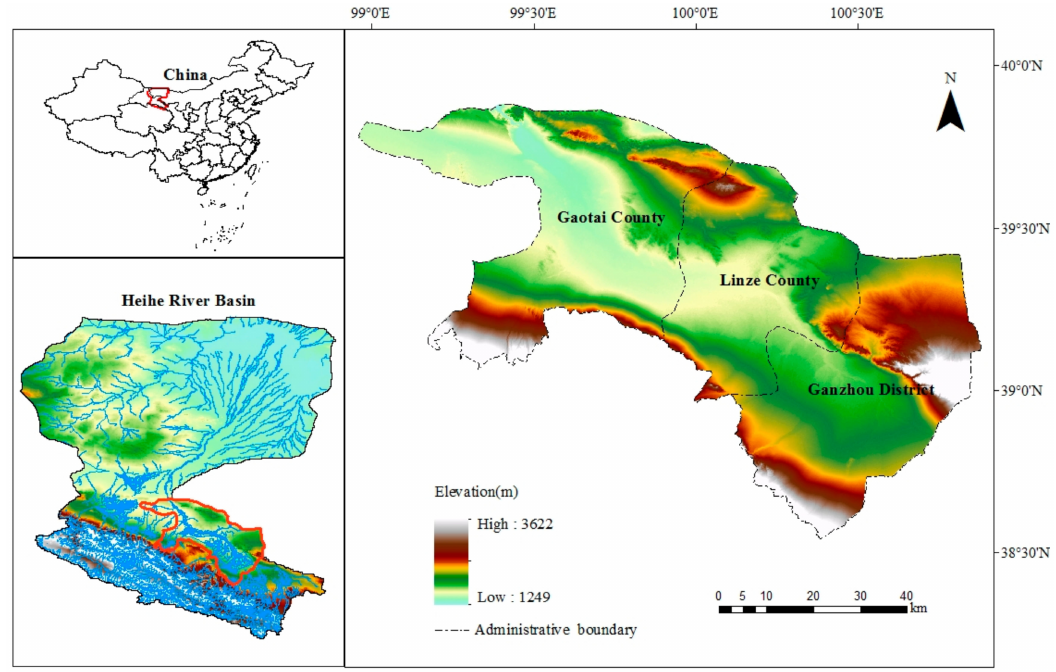
Figure 1. Map of the study area